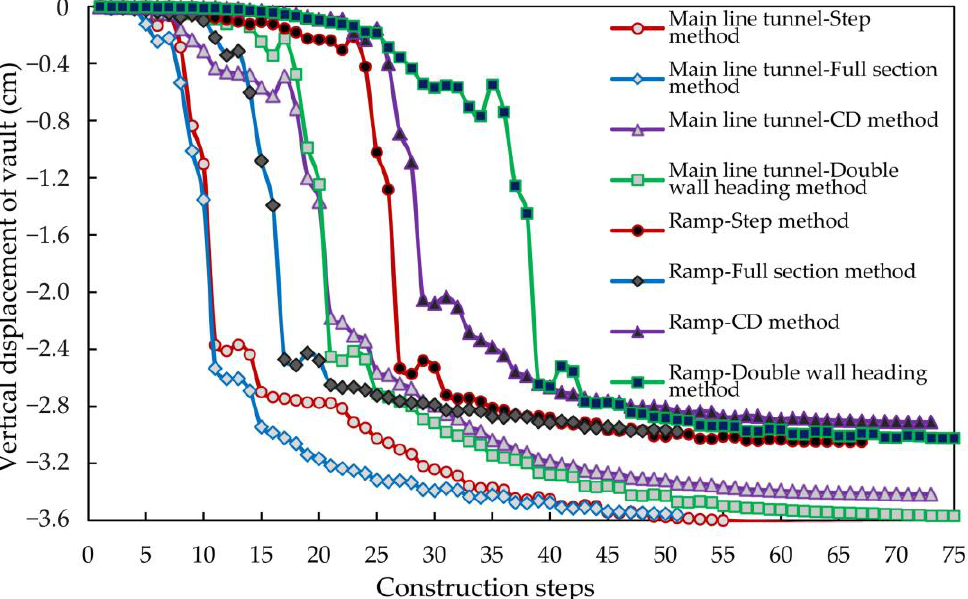
Figure 7. Variation curve of vertical displacement of the vault in the small clear-distance tunnel.